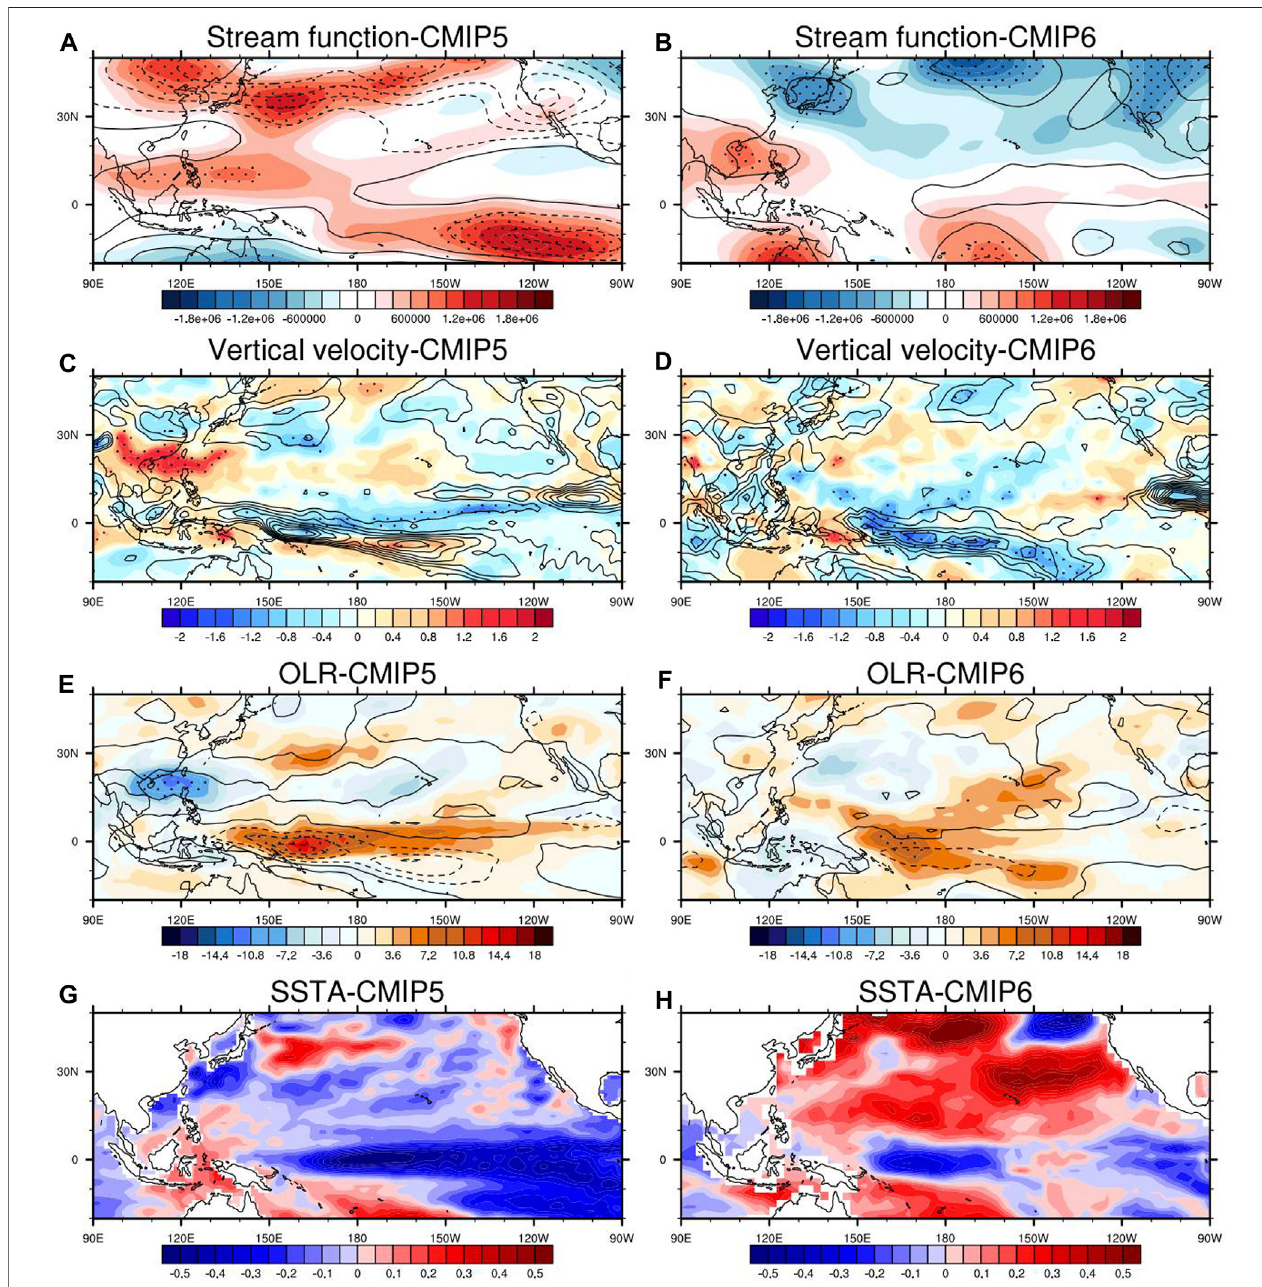
FIGURE 9 | The changes of the 850 hPa stream function anomaly (kg/s), the 500 hPa vertical velocity anomaly (kg/s), the OLR anomaly (W/m 2 ), and the SSTA ( D , ° C) during strong EP events in the following summer for CMIP5 ( A, C, E, G . RCP8.5-historical) and CMIP6 ( B, D, F, H . SSP5-85-historical) MME results.